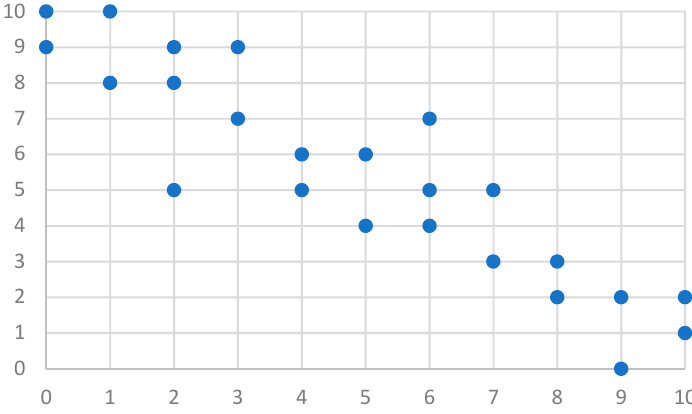
Figure 11. Example of negative correlation between variables (authors).